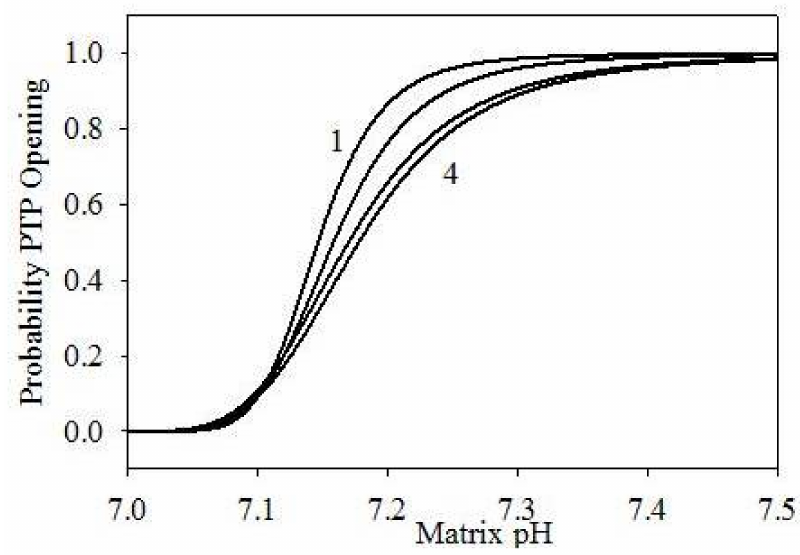
Figure 3. PTP opening probability in function of matrix pH, using different parametrizations: (1) α = 10 5 , n = 6; (2) α = 10 4 , n = 5; (3) α = 1.2 × 10 3 , n = 4; (4) α = 10 3 , n =